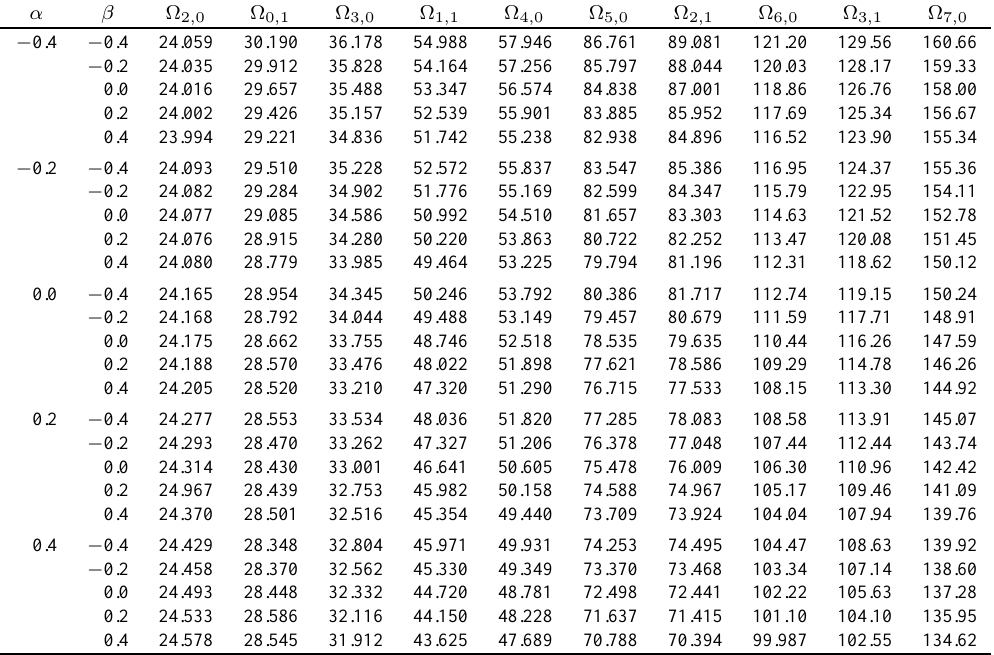
Table 11 Variation in Ω m,n with α and β for F - F plate when e r = g r = 5 . 0 , R 0 = 0 . 5 and K f =